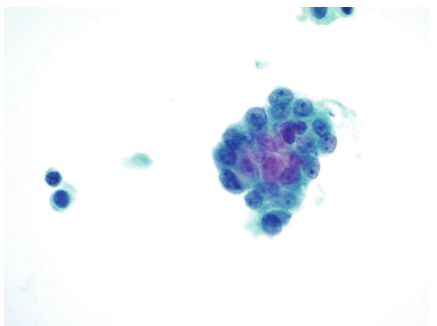
Figure 3: Liquid-based cytology slides contained rare crowded groups of lesional cells with nuclear overlapping, high nuclear/cytoplasmic ratios, open chromatin, and small but discernible nucleoli. These cells were difficult to differentiate from reactive mesothelial cells by microscopy (ThinPrep, Papanicolaou stain, 600x).